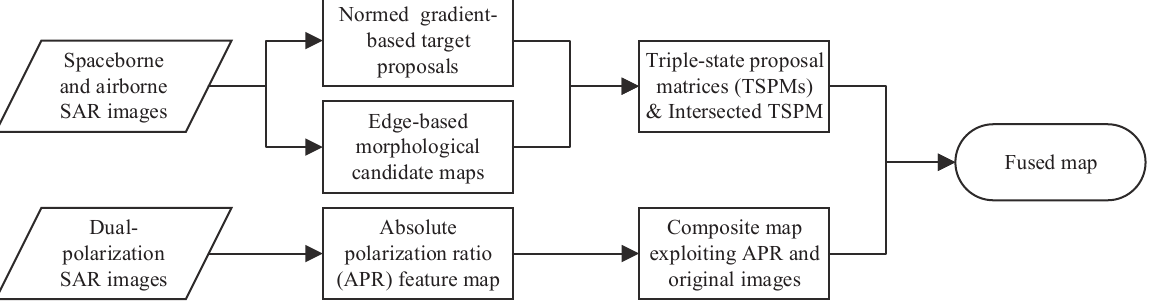
Figure 2. Flowchart of the proposed TPPIE image fusion